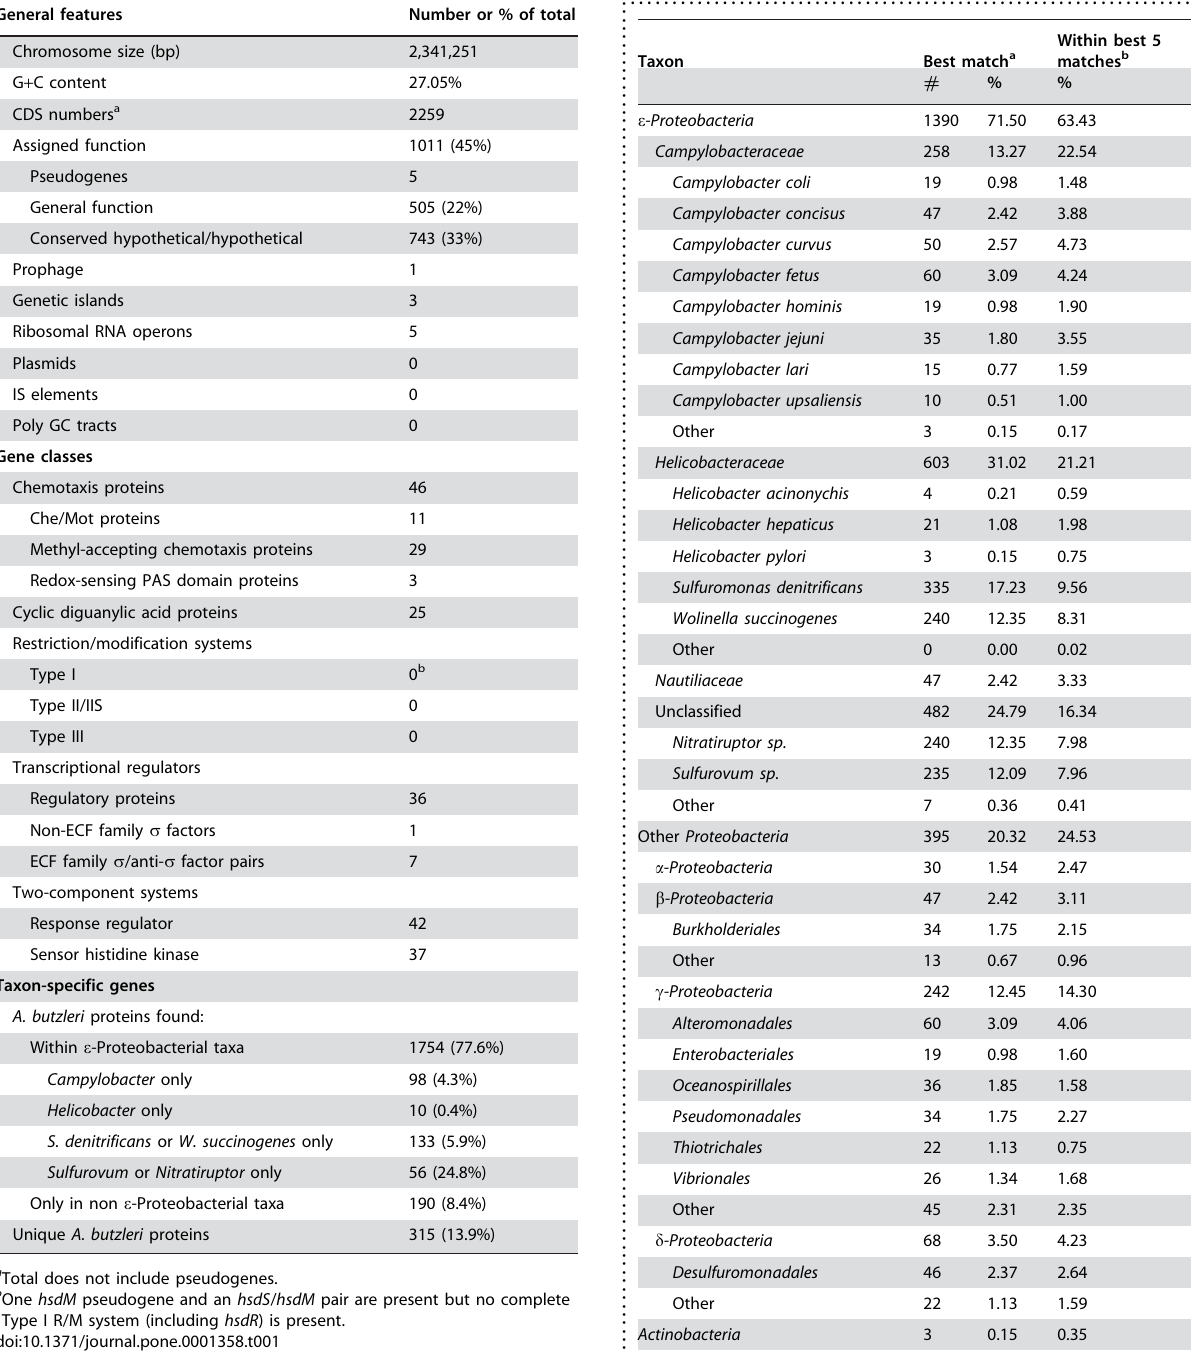
Table 2. Similarity of predicted A. butzleri proteins to